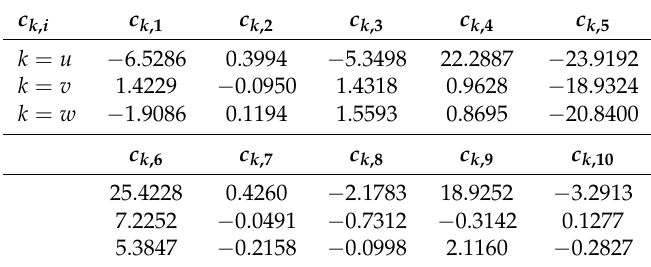
Table 10. H k ( x , y , z ) wake integral length scale regression